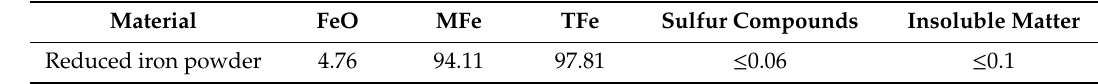
Table 1. The chemical composition of reduced iron powder (wt%).